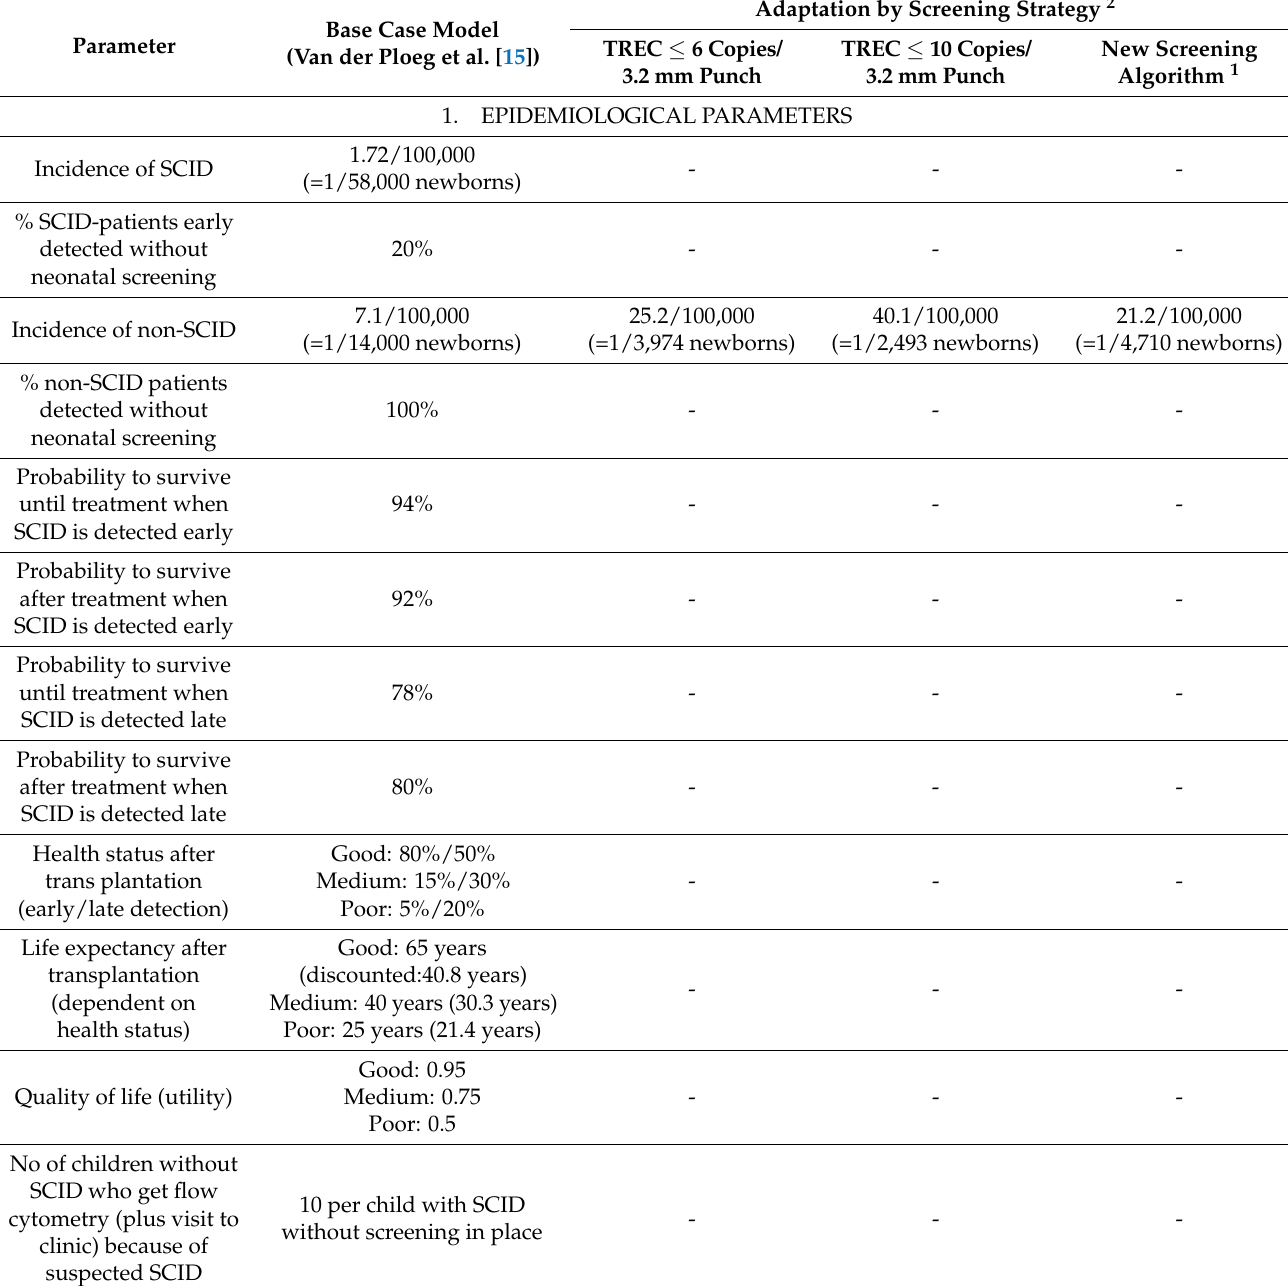
Table A1. Model parameters and their values in the model of Van der Ploeg et al. [15] and the adaptations made based on real-life data for the different screening strategies (TREC ≤ 6 copies/3.2 mm punch, TREC ≤ 10 copies/3.2 mm punch) and new screening algorithm 1 .